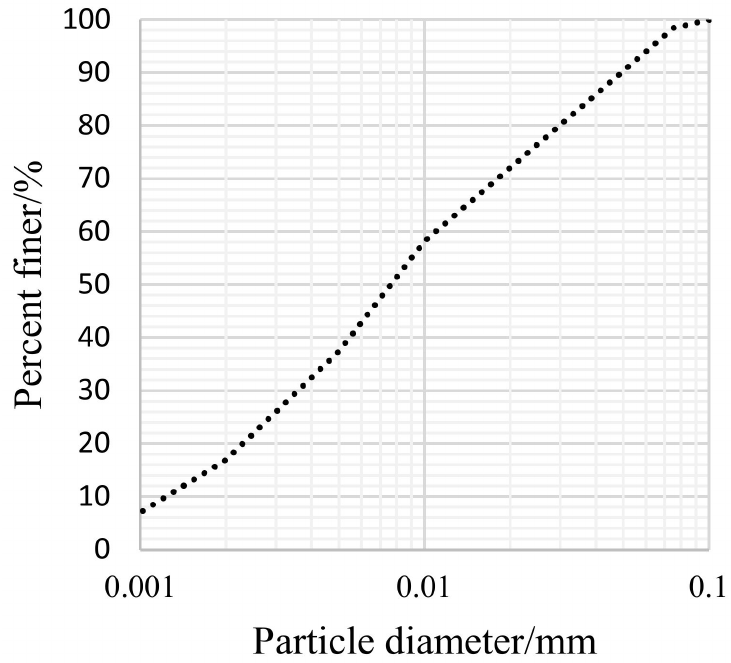
Figure 1. Grain size distribution of the Chengdu clay